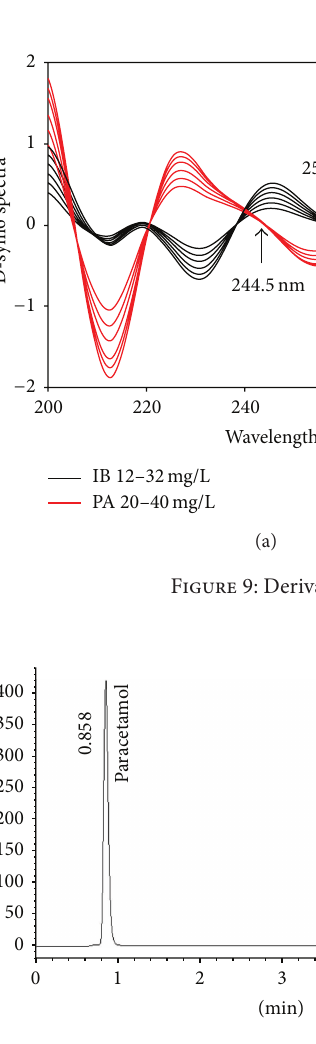
Figure 10: Typical liquid chromatogram of a binary mixture of IB 20 mg/L and PA 32.5